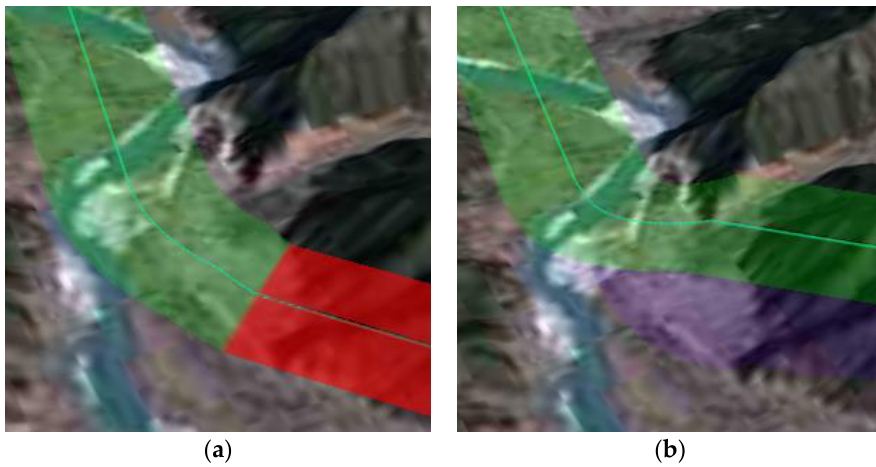
Figure 17. Route optimization with route buffer areas. ( a ) Before height adjustment; ( b ) After height adjustment.